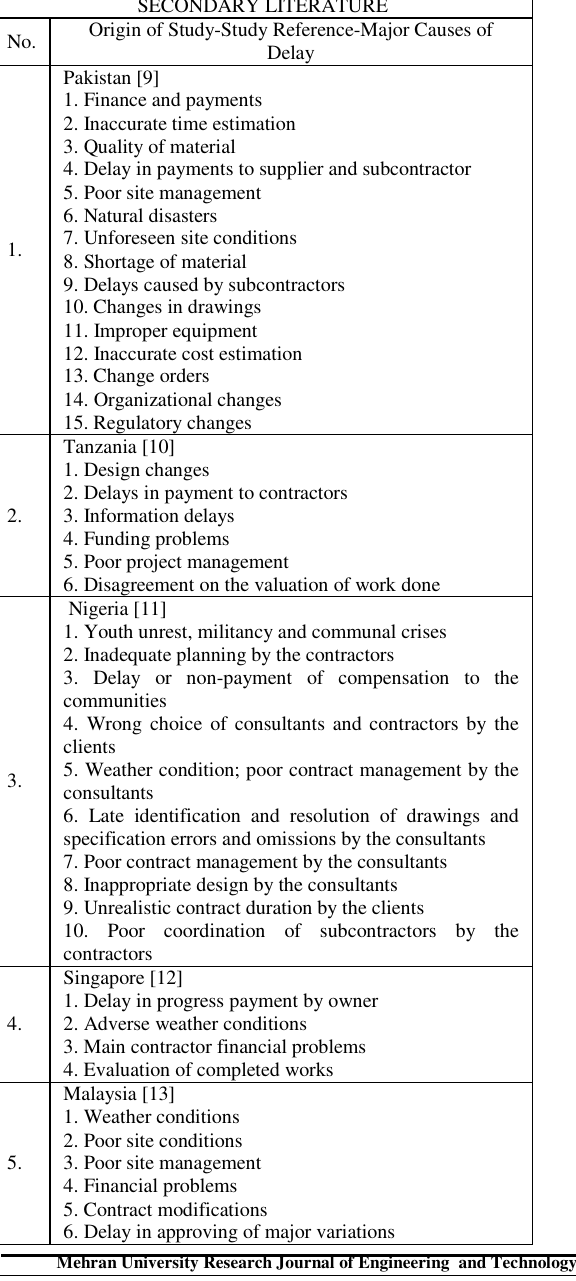
TABLE 1: MAJOR DELAY CAUSES HIGHLIGHTED IN SECONDARY LITERATURE Origin of Study-Study Reference-Major Causes of No. Delay